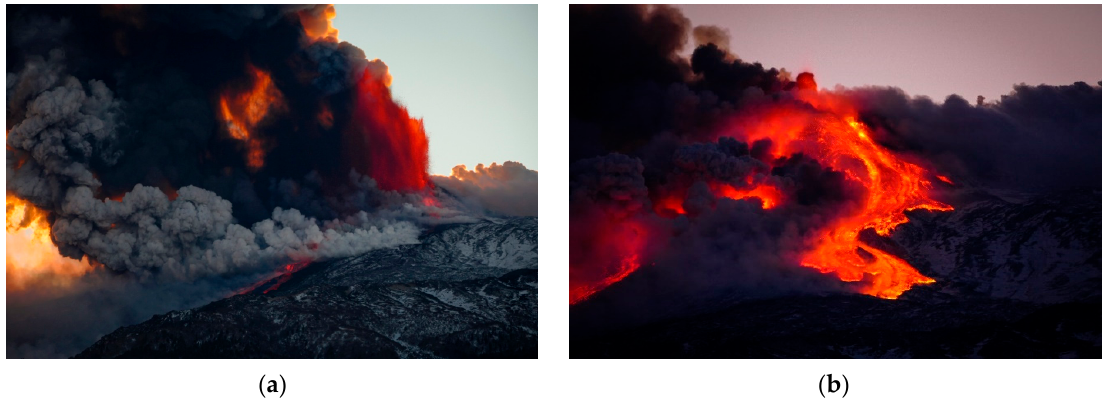
Figure 2. 16 February 2021, h:16:32–16:55 UTC (17:32–17:55 local time); shooting of the first paroxysmal eruption of Etna in the period February–April 2021, captured from north-east. ( a ) The jets of incandescent magma are expelled above the eruptive vent up to 300–400 m high, while the dark eruptive cloud expands to the east. ( b ) In the lower centre, the lava overflows erupted from the Southeast Crater can be seen. Photos by Giò Giusa.